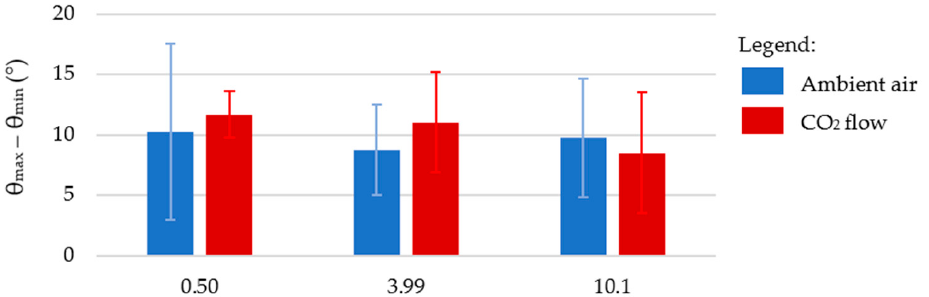
Figure 13. The θ max − θ min values for the samples for which the square pillars’ top was irradiated with different fluences, in ambient air or under a CO 2 flow. These values were measured on day 252 and at 90° of surface inclination.